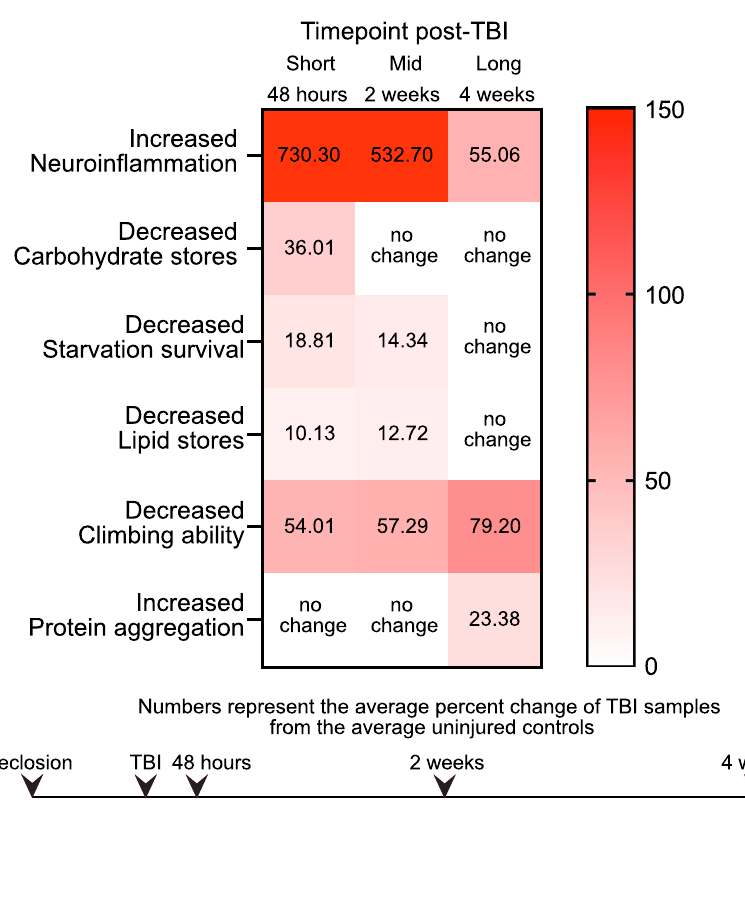
Figure 5. TBI induces molecular and physiological changes with different temporal patterns. Average percent change values of TBI-treated flies relative to the average uninjured control value at each timepoint post-TBI were calculated for samples that displayed a statistically significant difference. Increasing shades of red represent greater magnitudes of TBI-induced change in the phenotype (see left-hand description for increase or decrease relative to uninjured controls). Scaled timeline of when the injury is delivered and when timepoints are measured, starting with day of eclosion is